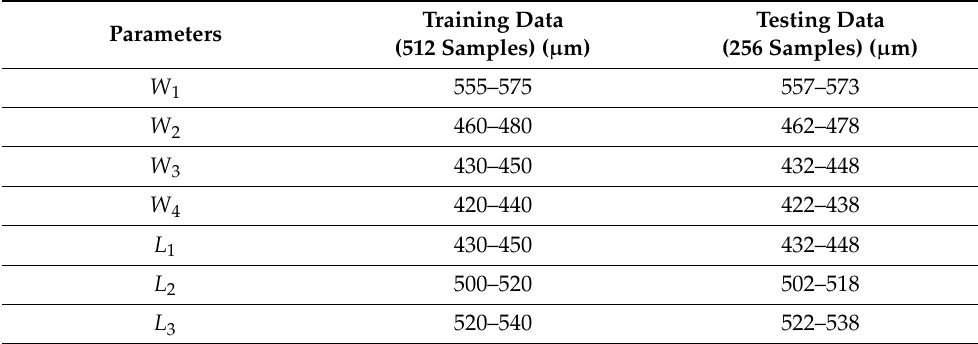
Table 2. The range of the training and testing data.